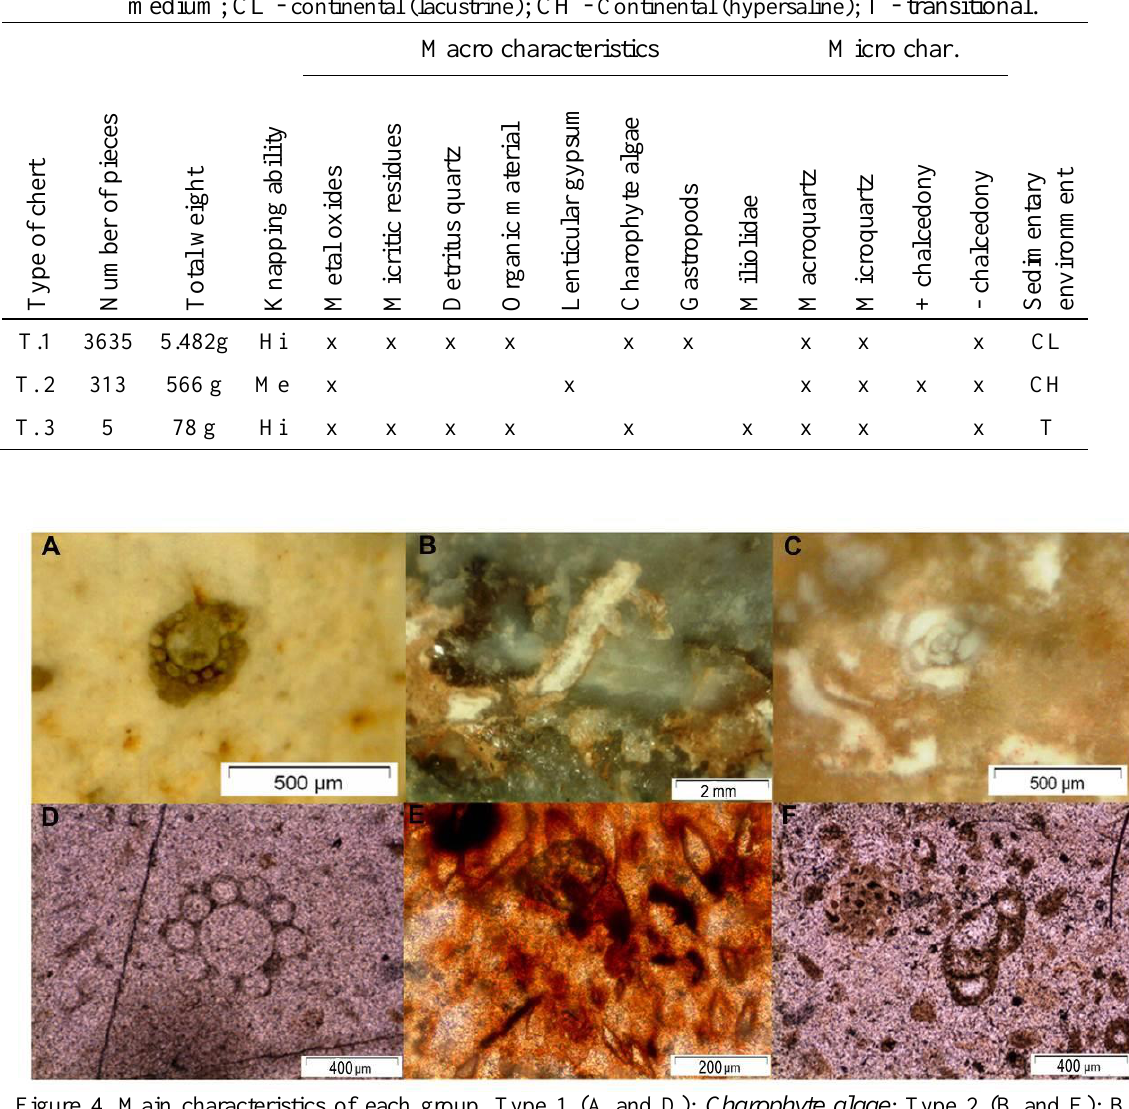
Table 2 – Main characteristics of each type of chert identified. Abbreviations: Hi - high; M - medium; CL - continental (lacustrine) ; CH - Continental (hypersaline); T - transitional.